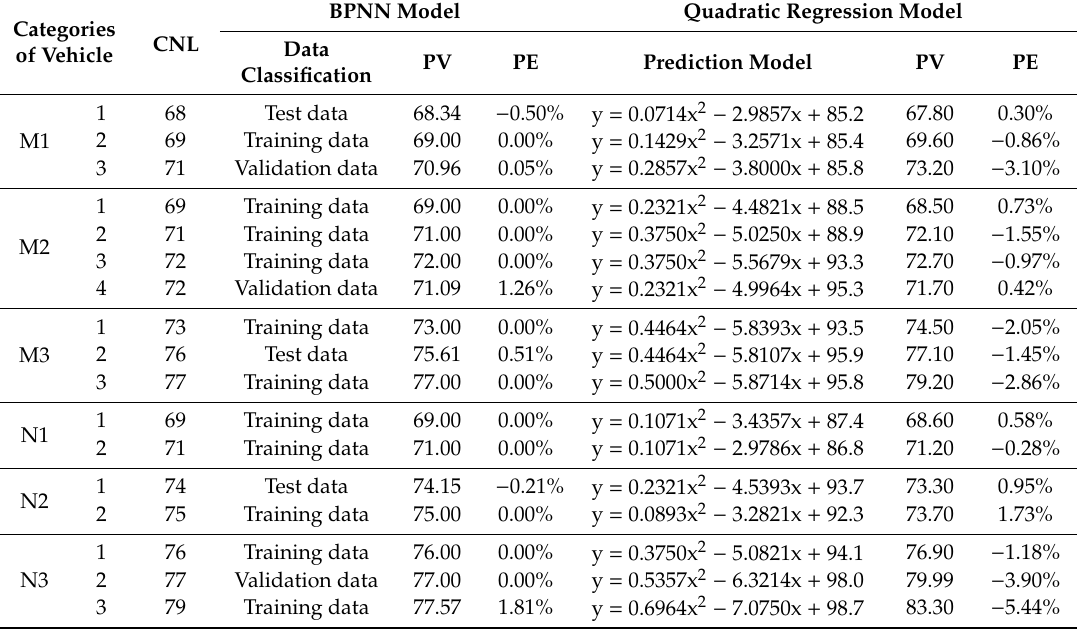
Table 4. Comparisons on prediction values extracted from the proposed BPNN model and quadratic regression